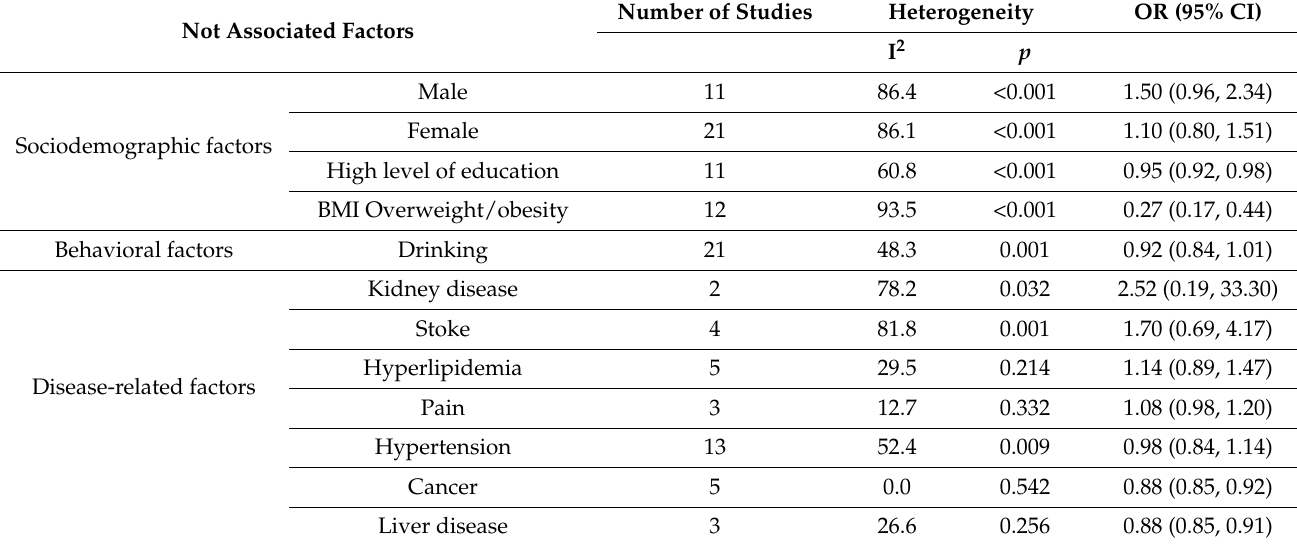
Table 2. Pooled ORs and 95% confidence interval for not associated factors of sarcopenia in community-dwelling older adults. Not Associated